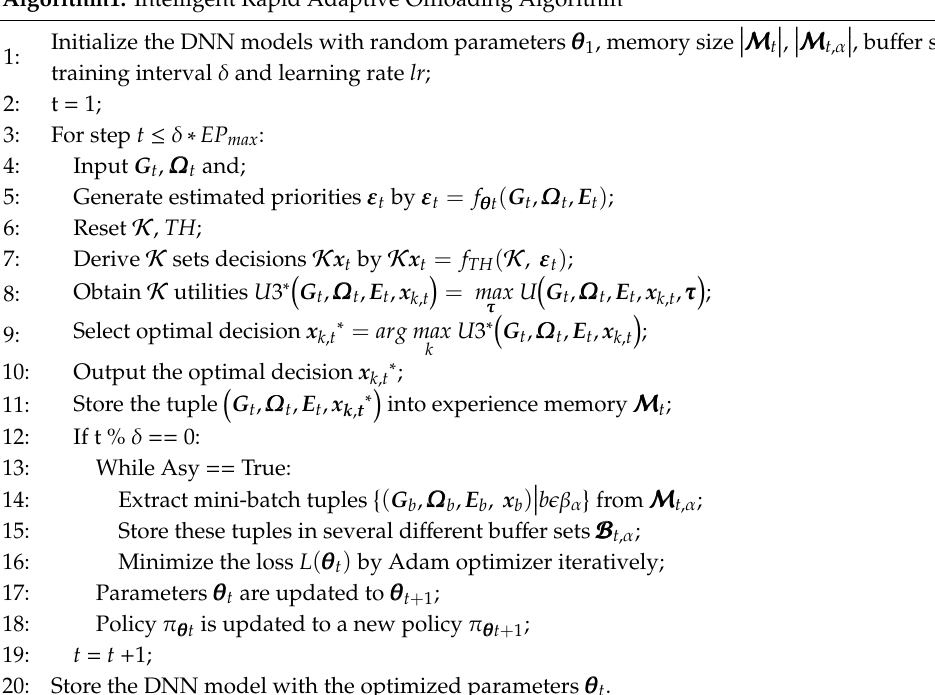
Figure 3. Training process of asynchronously trained deep neural network (AsyDNN) model. Algorithm1: Intelligent Rapid Adaptive O ffl oading